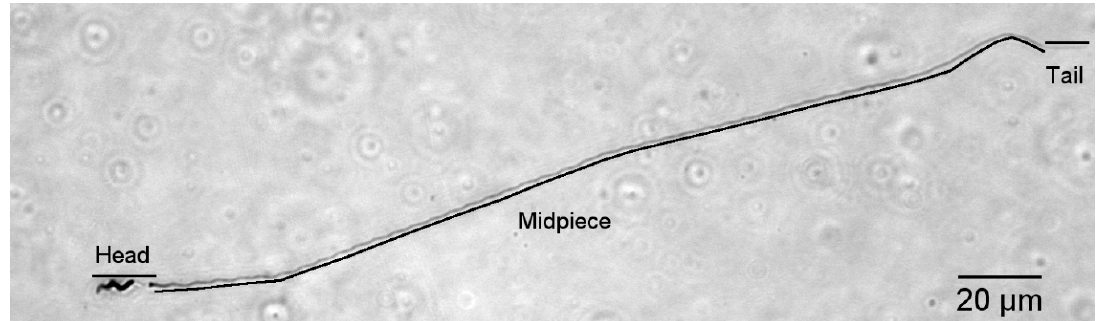
Figure 1. A single, Coomassie-blue stained spermatozoan from a black-throated blue warbler (400× total magnification). The sections measured as head, midpiece and tail (exposed flagellum) are labelled. The unstained portion of the head fluoresced strongly with a DAPI stain in pilot work.